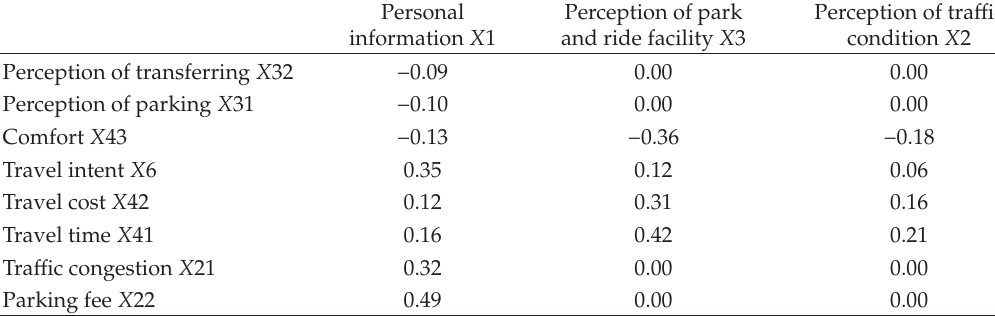
Table 4: The standard indirect